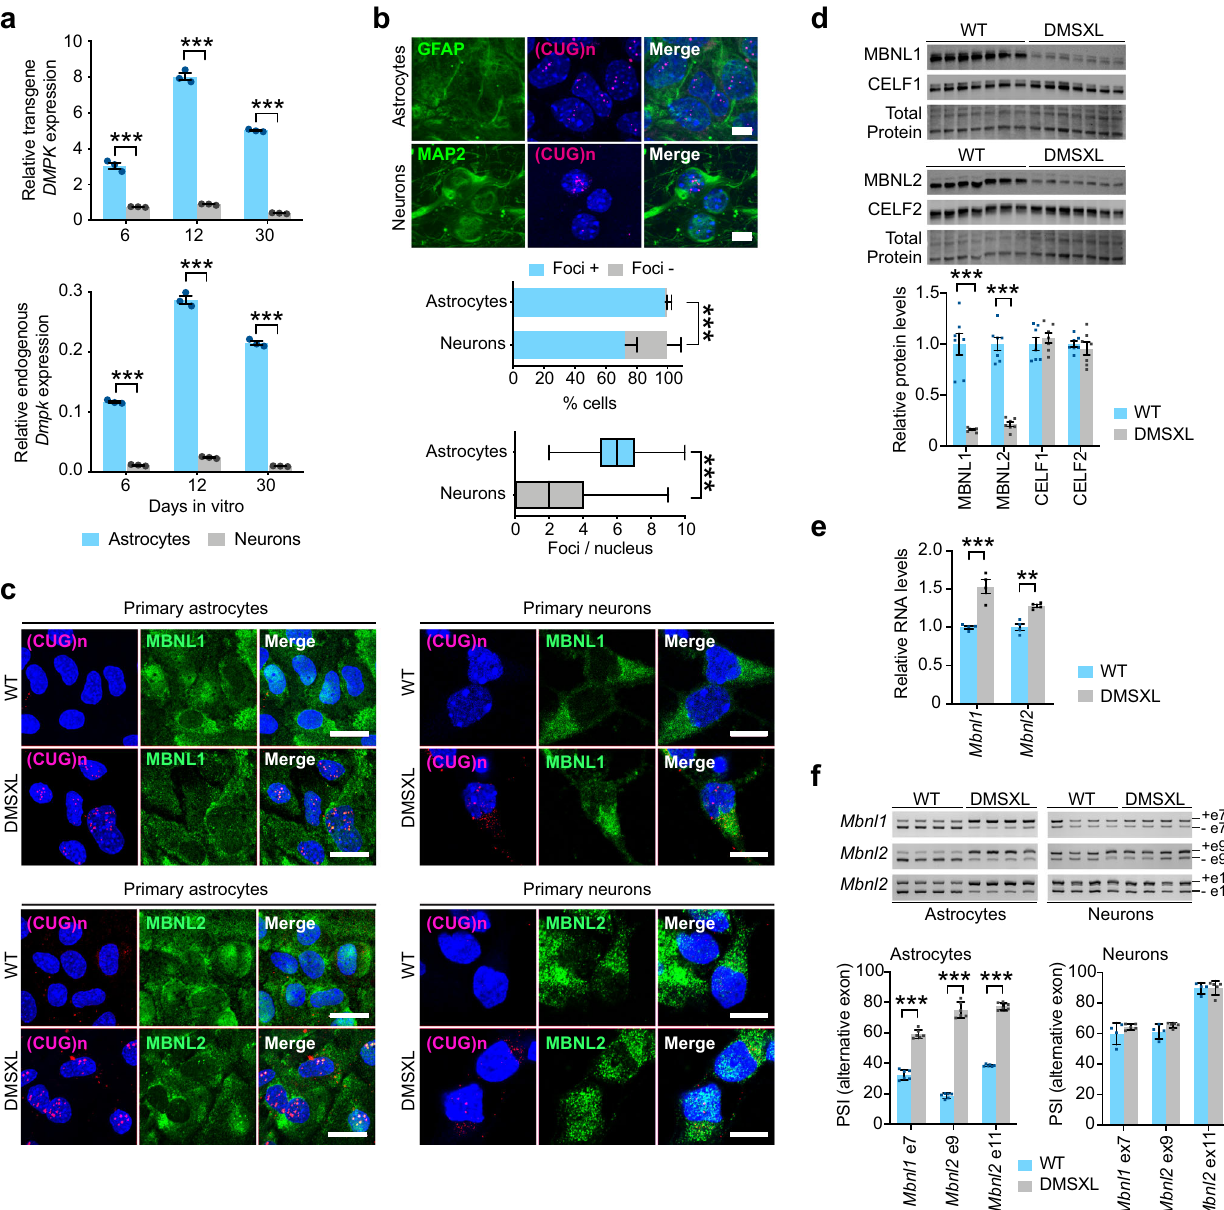
Fig. 6 DM1 RNA toxicity is more pronounced in mouse astrocytes than in neurons. a Quantitative RT-PCR expression analysis of human DMPK transgene and mouse endogenous Dmpk relative to 18S rRNA internal control in primary DMSXL astrocytes and neurons at 6, 12, and 30 days in vitro. Data are means ± SEM, n = 3 independent cultures per group ( p < 0.0001, Two-way ANOVA, Sidak post hoc pair-wise comparisons). b FISH analysis of nuclear foci accumulation in primary DMSXL astrocytes and neurons. Percentage of GFAP-expressing astrocytes and MAP2-expressing neurons containing foci ( p < 0.0001, χ 2 test). Data are means ± SEM. Tukey whisker plots represent the number of foci per nucleus in primary DMSXL astrocytes and neurons ( p < 0.0001, Two-tailed Mann – Whitney U test). The plots display the median and extend from the 25th percentile up to the 75th percentiles. The whiskers are drawn down to the 10th percentile, and up to the 90th percentile. N = 3 independent cultures per cell type; n = 217 astrocytes; n = 125 neurons. Scale bar, 10 µ m. c FISH of RNA foci (magenta) combined with IF detection of MBNL1 and MBNL2 (green) in primary astrocytes and neurons of DMSXL and WT mice. Scale bar, 10 µ m. Nuclei are stained with DAPI (blue). The experiment was performed on three independent cultures of each genotype. d Western blot quanti fi cation of MBNL and CELF proteins in primary astrocytes and neurons from DMSXL and WT mice. MBNL1 and MBNL2 were detected with antibodies raised against recombinant full length human proteins. Representative stain-free protein bands are shown to illustrate total protein loading. Data are means ± SEM, n = 7 independent cultures per genotype ( p < 0.0001, MBNL1, MBNL2; p = 0.9199, CELF1, p = 0.9728; CELF2; Two-way ANOVA, Sidak post hoc test for multiple comparisons). e Quanti fi cation of Mbnl1 and Mbnl2 transcripts in primary DMSXL astrocytes and neurons, relative to WT controls. Data are means± SEM, n = 4 independent cultures per genotype ( p < 0.0001, Mbnl1 ; p = 0.0054, Mbnl2 ; Two-way ANOVA, Sidak post hoc pair- wise comparisons). f Representative RT-PCR splicing analysis of Mbnl1 and Mbnl2 transcripts in primary astrocytes and neurons. The graphs show the PSI of alternative exons. Data are means ± SEM, n = 6 independent cultures per genotype ( p < 0.0001; Two-way ANOVA, Sidak post hoc test for multiple comparisons). Source data are provided as a Source Data fi le. ** p < 0.01; *** p <